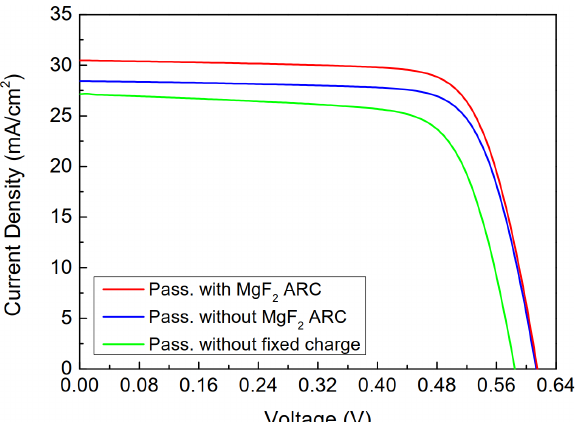
Figure 13. Simulated J–V curves of different u-CIGS solar cell models (d CIGS = 500 nm, W = 200 nm, p = 1.5 µ m, and D it of 1 × 10 10 eV − 1 cm − 2 Table 3. PV characteristics of different u-CIGS models.